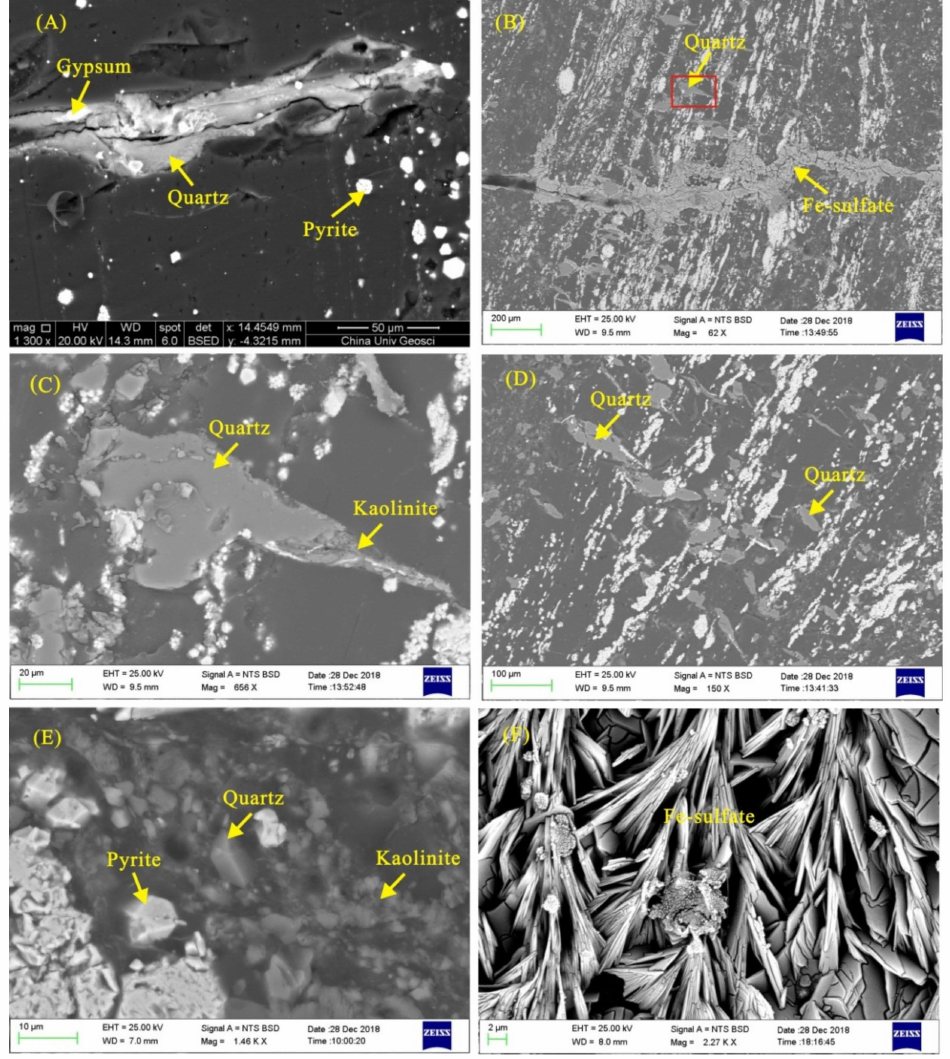
Figure 9. SEM back-scattered electron images of minerals in the coal sample (sample CLB4-12) and floor sample (sample CLB4-F1). ( A ): fracture-filling quartz and gypsum; ( B ): fracture-filling quartz and Fe-sulfate; ( C ): fracture-filling quartz, with kaolinite occurring along the outer edge of quartz; ( D ): fracture-filling quartz; ( E ): kaolinite matrix, dispersed pyrite particle, and euhedral quartz grain; ( F ): needle-like